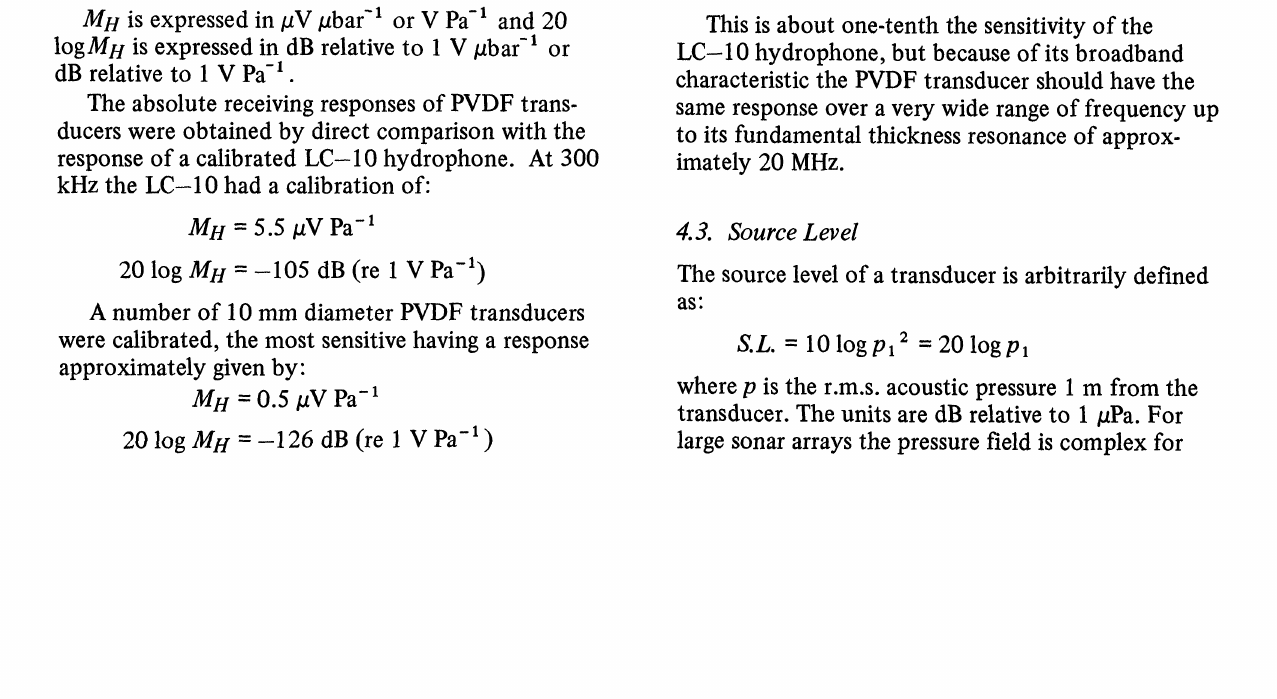
O0 20 TEMPERATURE (C) FIGURE 6 Relative receiving response as a function of temperature for different poling